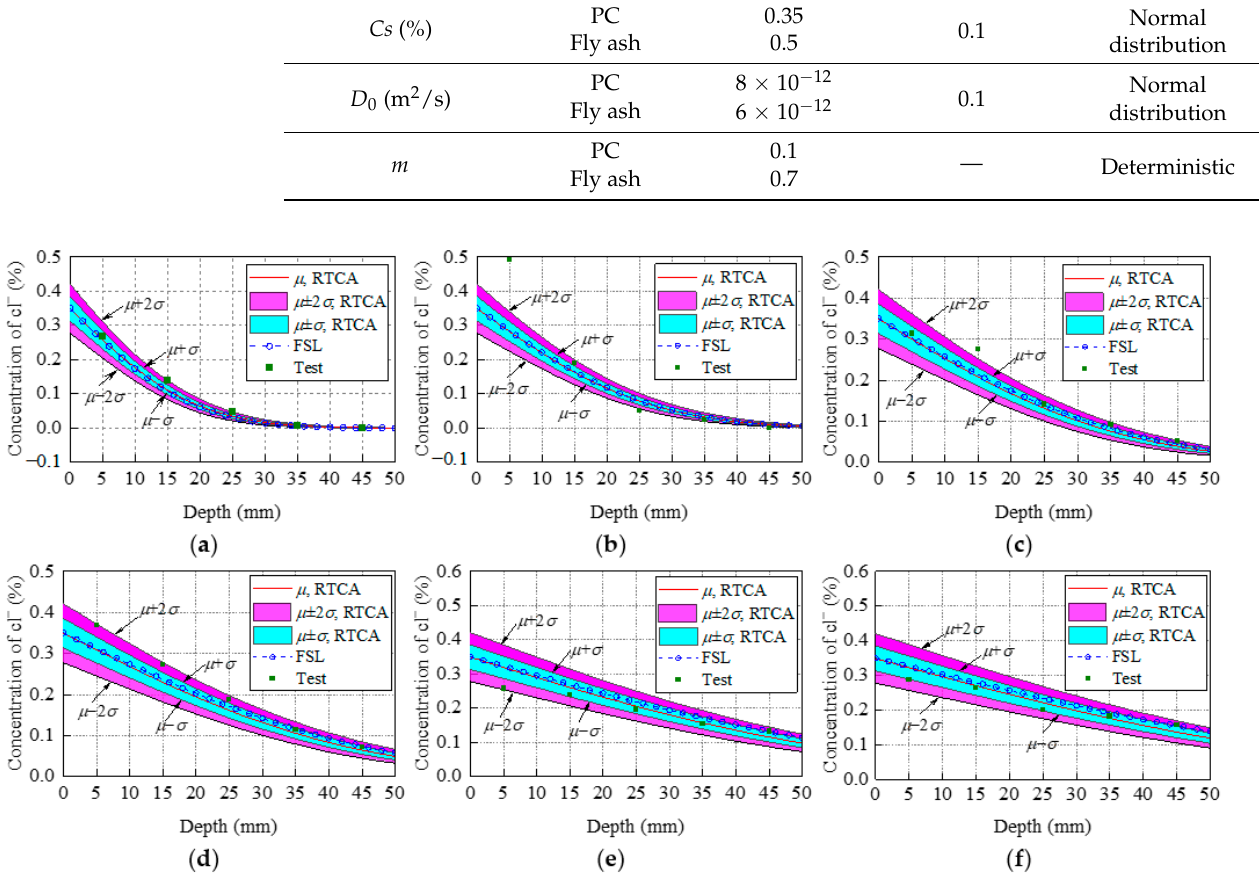
Figure 8. Comparisons between the statistical result ( µ σ ) using the 3D RTCA model, FSL analytical solution, and test data for PC concrete: ( a ) t = 0.5 year; ( b ) t = 1 year; ( c ) t = 2 years; ( d ) t = 3 years; ( e ) t = 6 years; ( f ) t = 8